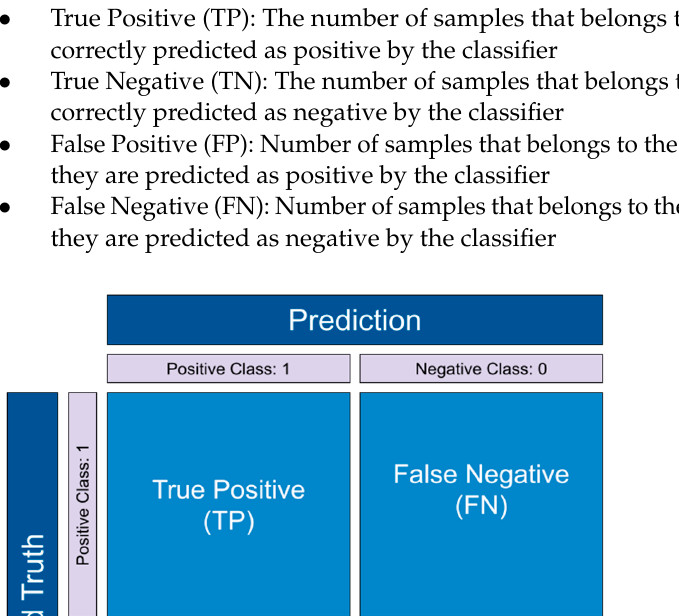
2.48 Based on Table 5, the first column indicates the number of attributes of each dataset. The second, the sum of positive and negative samples, is calculated as all samples. Further- more, the imbalance ratio between minority or positive and majority or negative classes is assigned in the third column. Meanwhile, the imbalance ratio is achieved by dividing neg- ative samples into positive samples. As described in Section 3.1.3 (split dataset), the dataset was randomly shuffled and split into training and testing sets which the dataset was trained according to the model for 2000 epochs. The generated models were trained and evaluated for 100 runs.